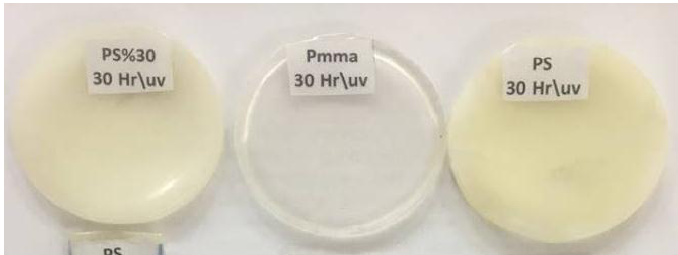
Fig.3: Shows 30hr uv for PMMA, PS,